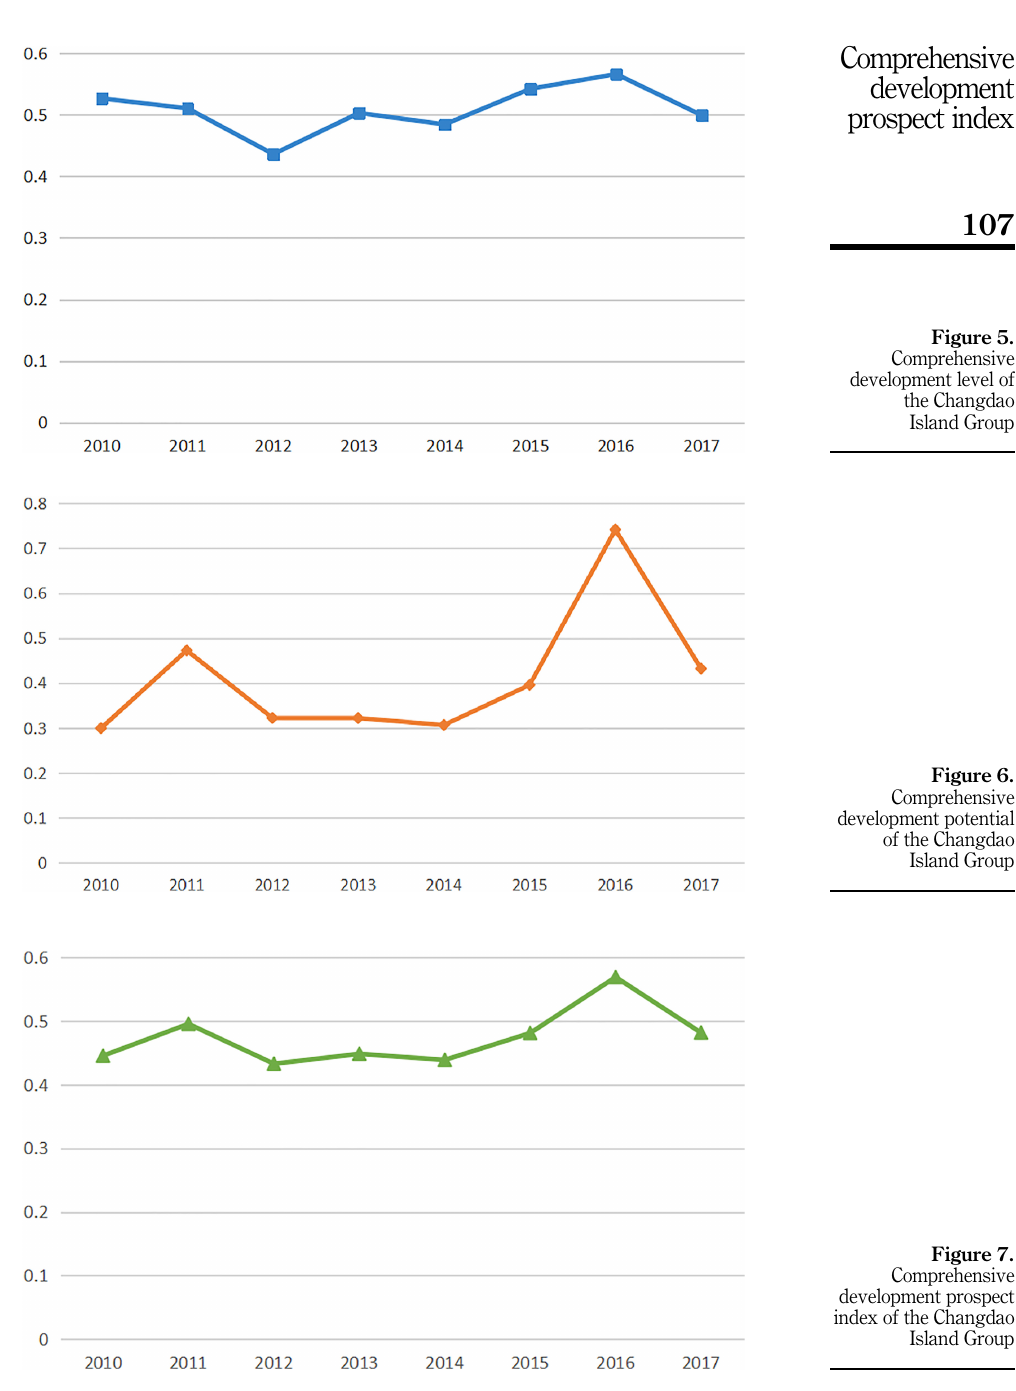
Figure 7. Comprehensive development prospect index of the